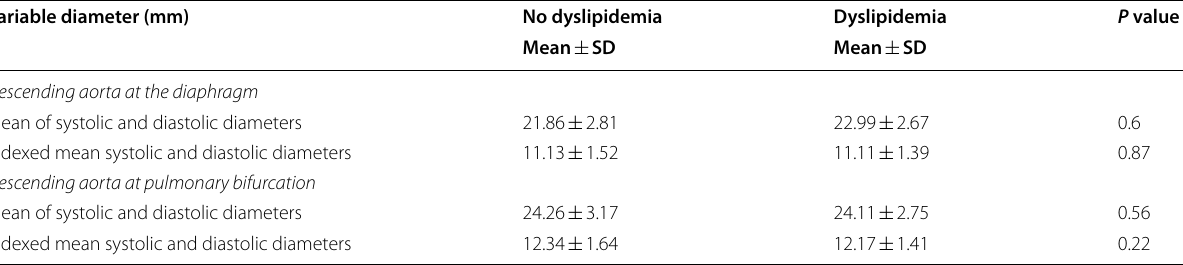
Table 22 Comparison of descending thoracic aorta diameters in dyslipidemic and non‑dyslipidemic individuals Variable diameter